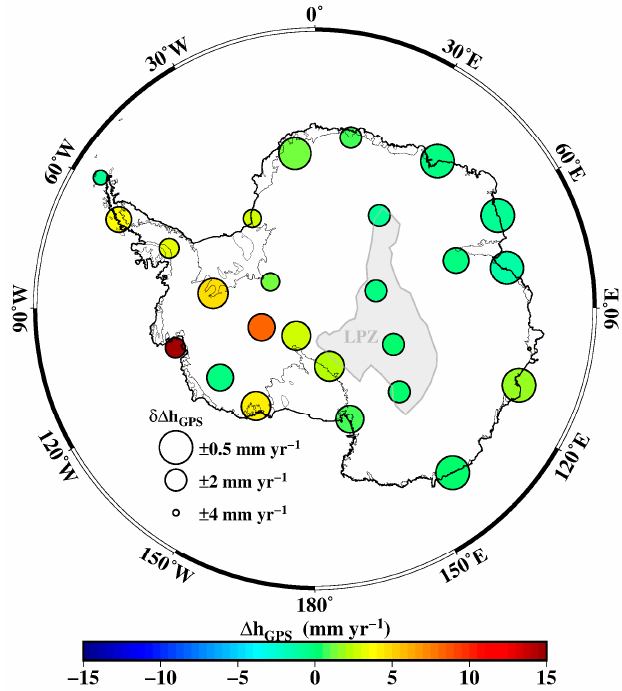
Figure 2. The Global Positioning System (GPS) observations for crustal uplift rates and corresponding uncertainties in Antarctica over the time span of 2003–2013. The radius of the circle denotes the uncertainty (as the radius is larger, the uncertainty becomes smaller). Gray area denotes low-precipitation zone (LPZ). The GPS data are from Sasgen et al. [79].